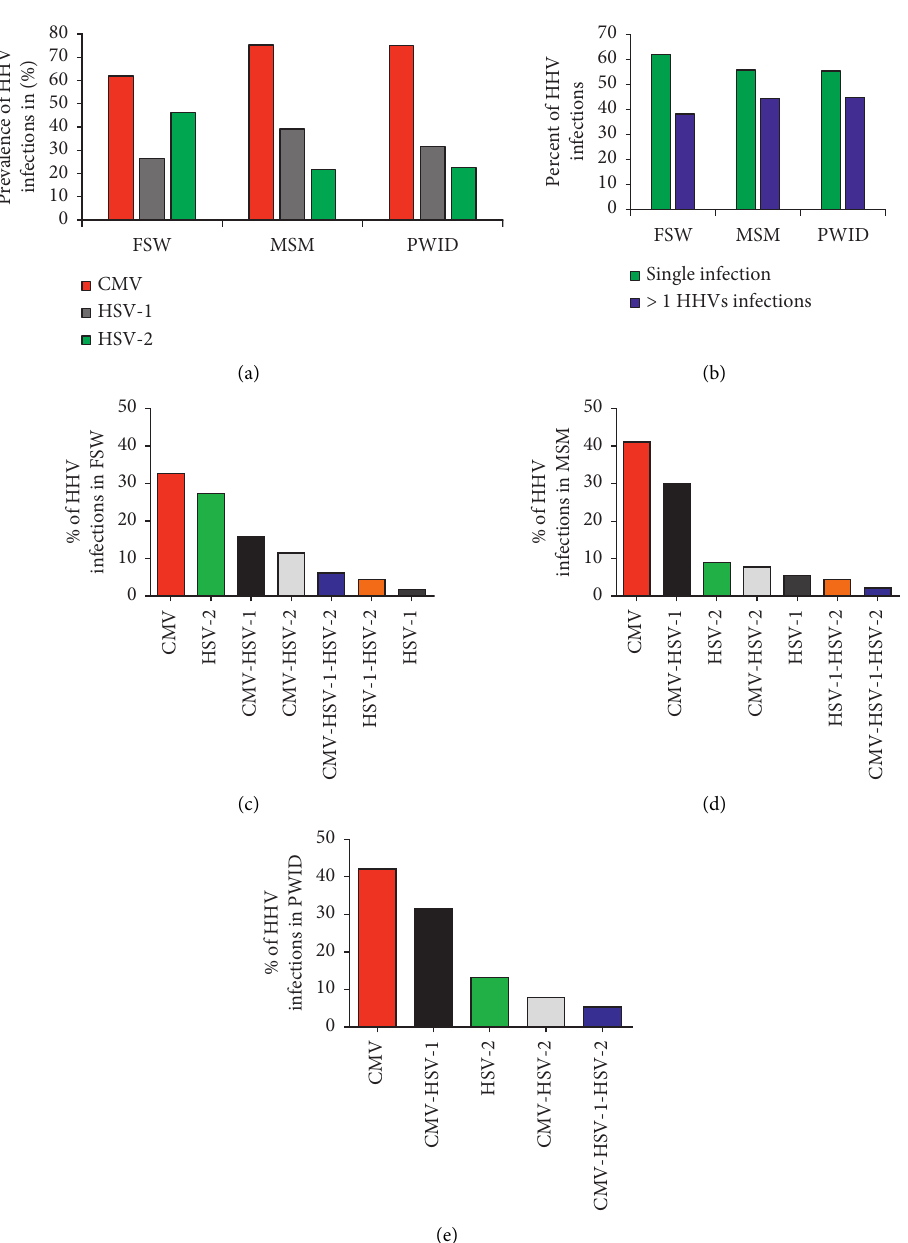
Figure 2: Distribution of HHV coinfections among HIV-infected key population groups. (a) The overall prevalence of HHVs (CMV, HSV- 1, and HSV-2) among the key populations FSW ( n � 121), MSM ( n � 97), and PWID ( n � 44). (b) The prevalence of single HHV (either CMV or HSV-1 or HSV-2) infection and multiple infections ( > more than 1 HHVs coinfections) across each key population who tested positive for IgG ( n � 241). Figures indicate the distribution of single and multiple HHV infections among (c) FSW, (d) MSM, and (e) PWID HIV- infected key populations who tested positive for IgG ( n �